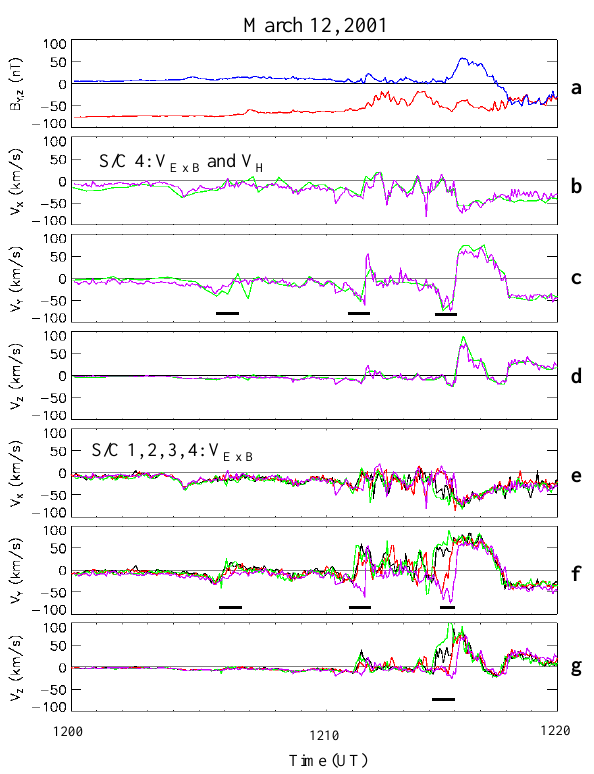
Fig. 13. Velocity comparisons from Cluster. (a) The Y and Z components of the magnetic field are shown for context. (b)–(d) The three perpendicular components of the ion velocity (blue) from Cluster 4 are compared with the velocity determined by E × B . (e)– (g) E × B velocities from all 4 spacecraft are overlaid (1 – black; 2 – red; 3 – green; 4 – magenta).